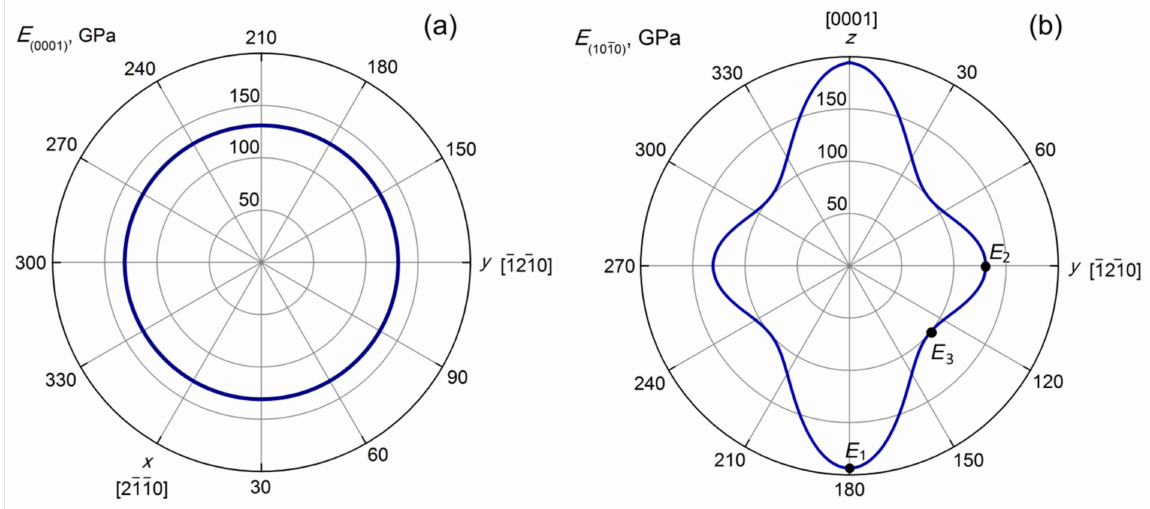
(cid:0) (cid:1) 1010 ( b ) planes of the CeF 3 single crystal.